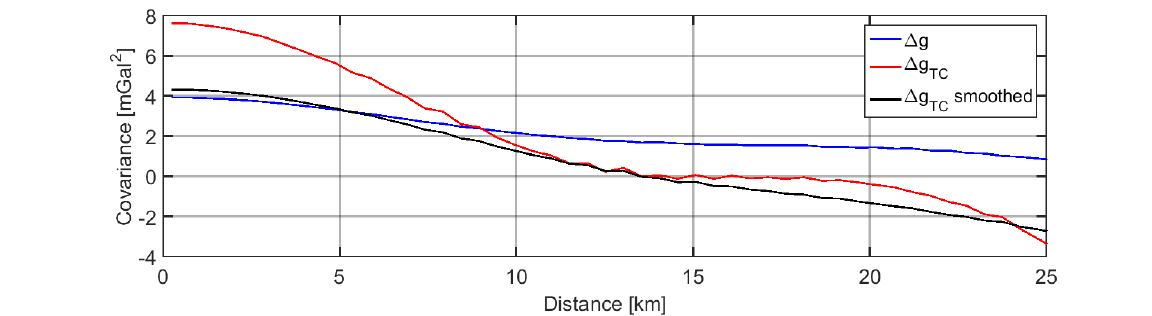
Figure 8. Covariance of ∆ g (blue line) of the gravitational effect of the etopo1 model (red line) and of the gravitational effect of the etopo1 model smoothed by means of a moving average with size 5 km (black